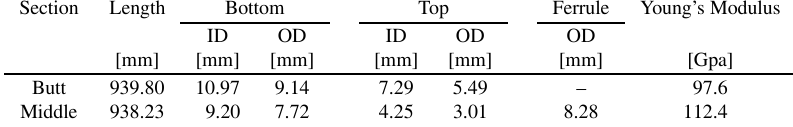
Table 4 Fly rod dimensions and material properties(O., outer, I., inner; D., diameter)